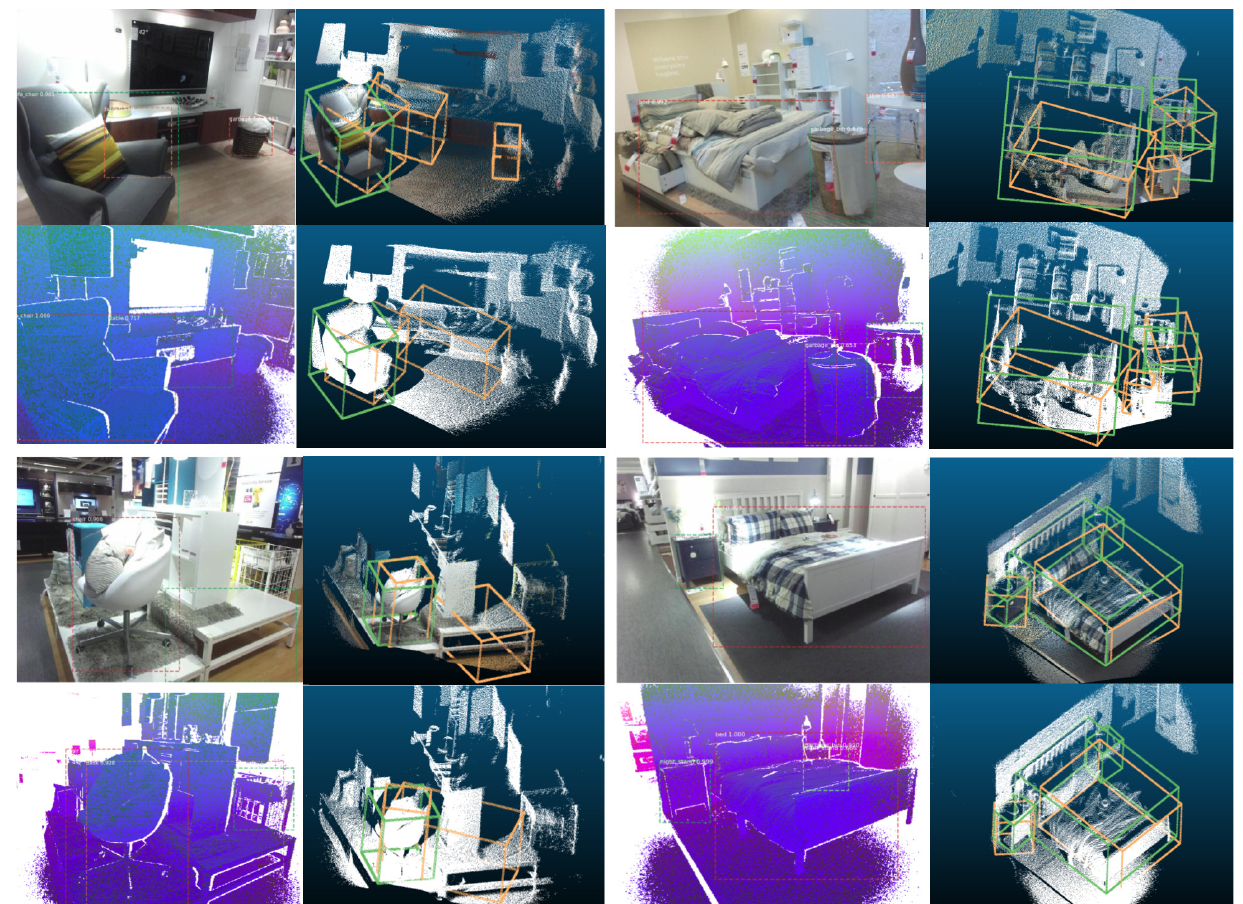
Figure 13. Visualizations of 2D and 3D detection results part 2. Please read the caption of Figure 12 to get an explanation about how to understand the